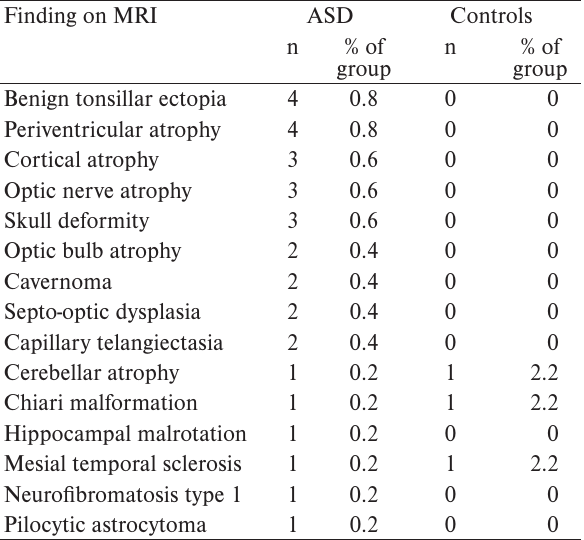
Table 3. Summary of uncommon MRI findings in the ASD and the control groups.